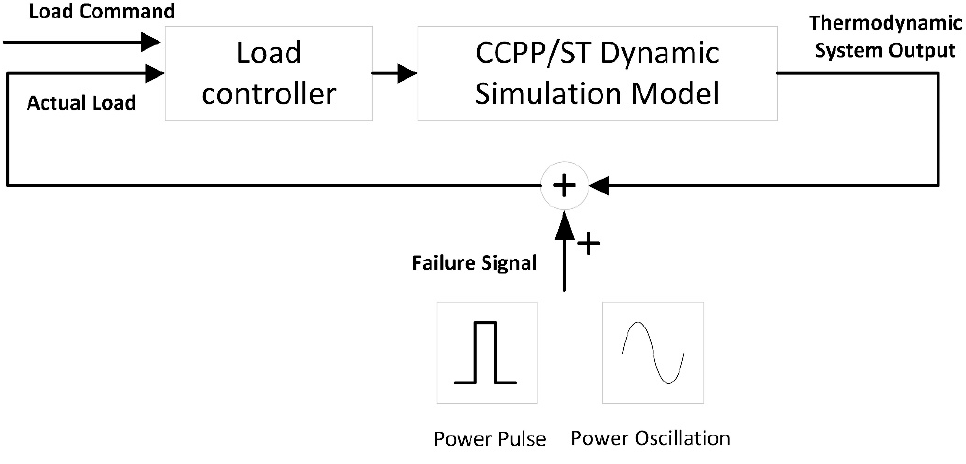
Figure 6. Fault simulation model of single-shaft CCPP.